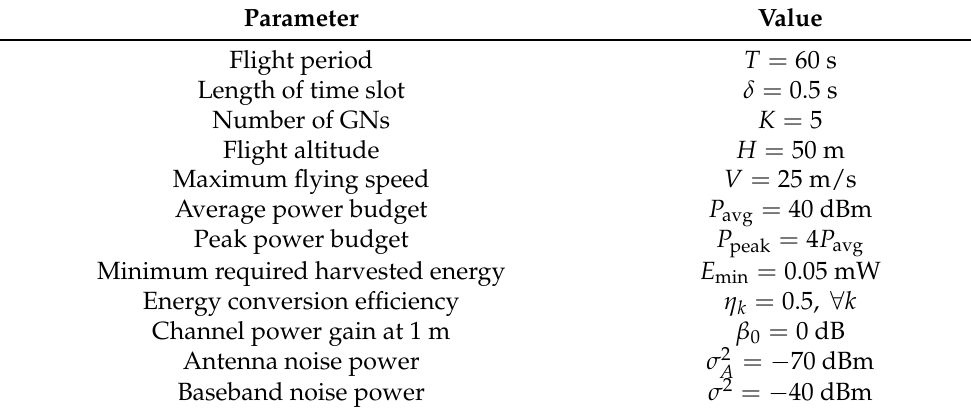
Table 1. Parameter setup.